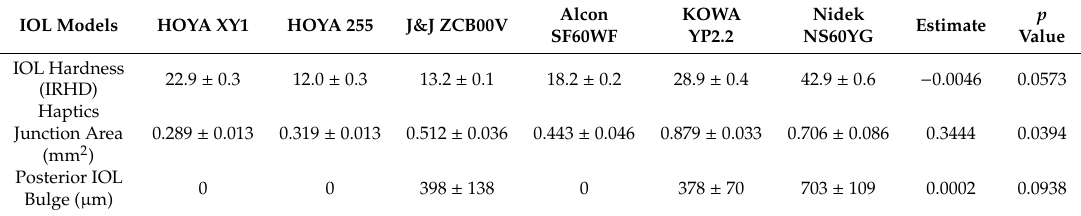
Figure 4. Correlation between the IOL displacement force and IOL hardness ( a ), haptics junction area ( b ), and posterior IOL bulge ( c ). P values and regression coefficient ( R ) are calculated by linear regression analyses. Table 4. IOL hardness, haptics junction area, and posterior IOL bulge in each IOL model.